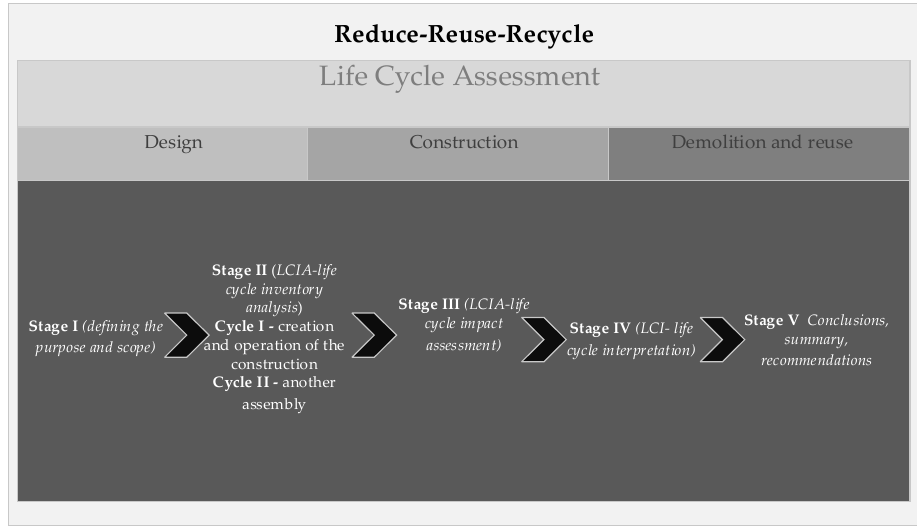
Figure 1. The methodological framework of the presented scientific approach to determining ecological and economic benefits.